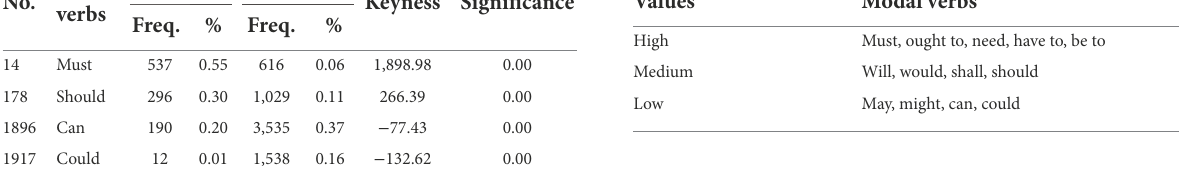
TABLE 16 Key modal verbs in CWM (in comparison with BNC-S).